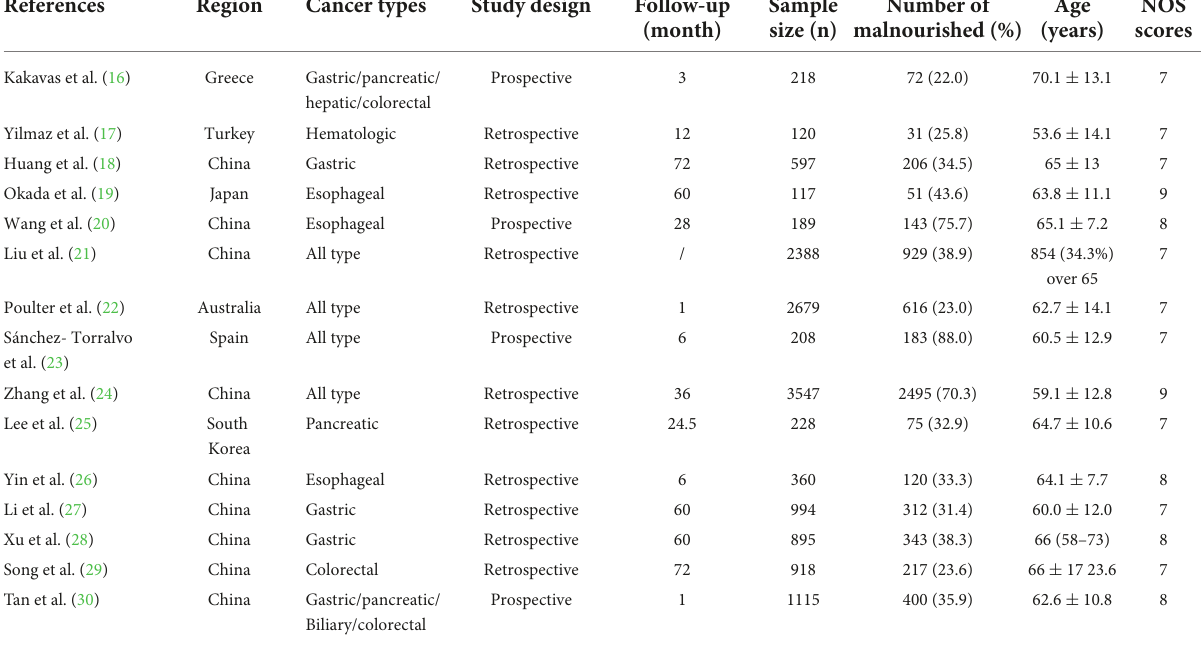
TABLE 1 Characteristic of the included